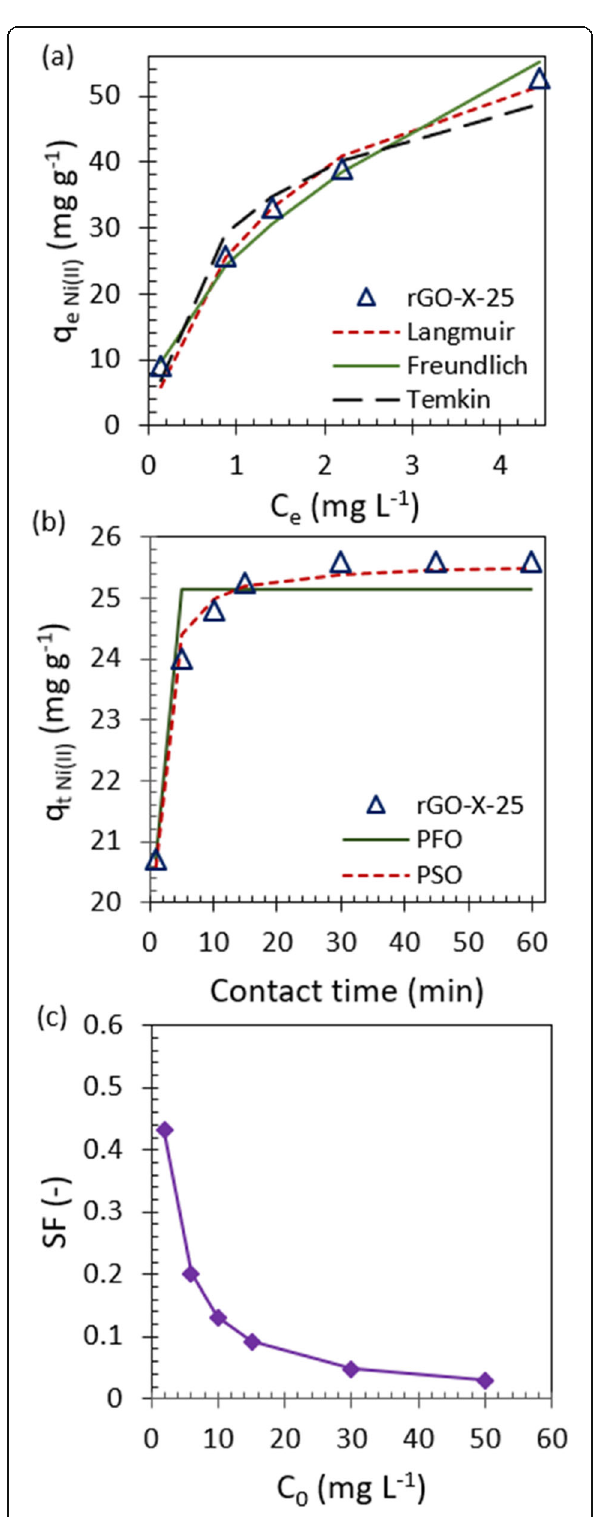
Fig. 4 Non-linear ( a ) isotherm and ( b ) kinetic models for Ni (II) removal using rGO-X-25. ( c ) Separation factor plot of rGO-X-25 for Ni (II)